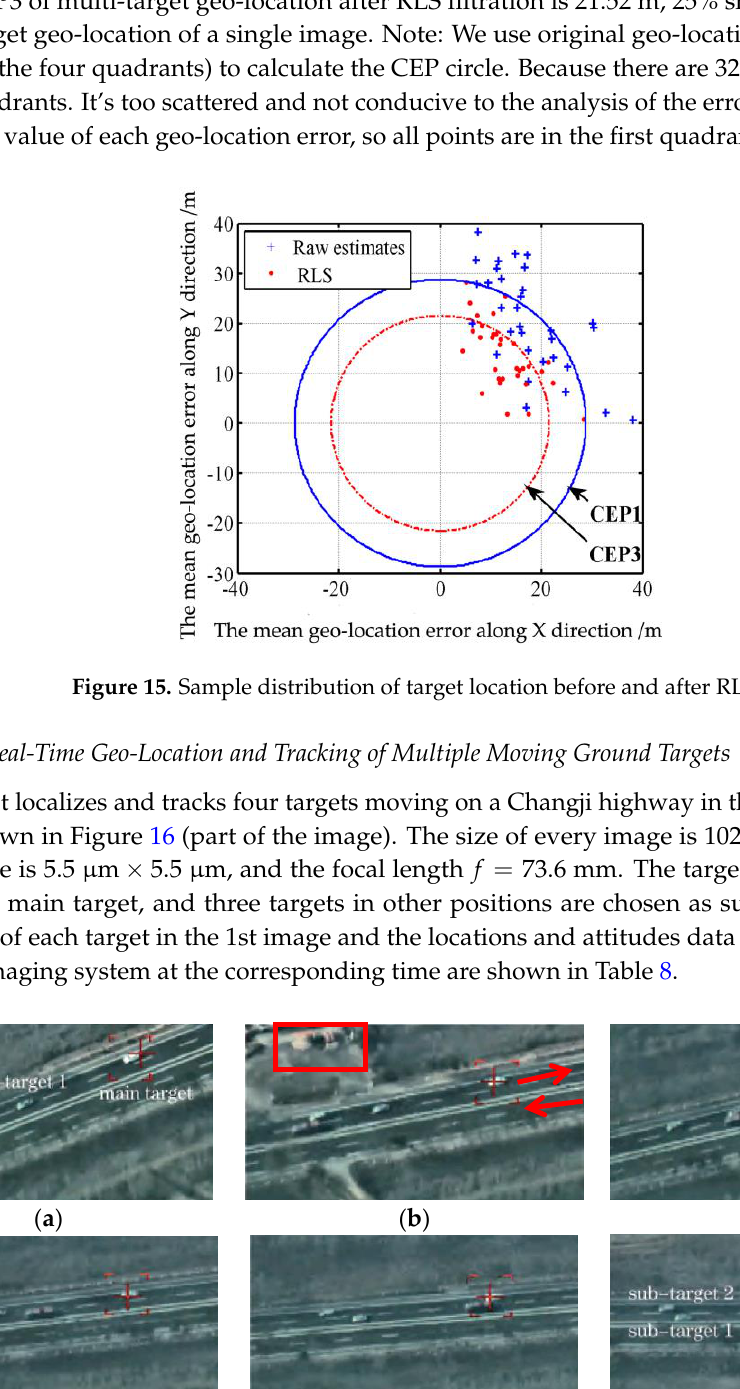
Table 8. Locations and attitudes data of electro-optical stabilized imaging system.